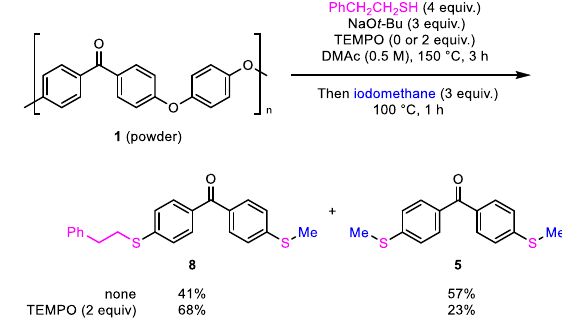
Fig. 4 Depolymerization of PEEK at the early stage. TEMPO does not affect